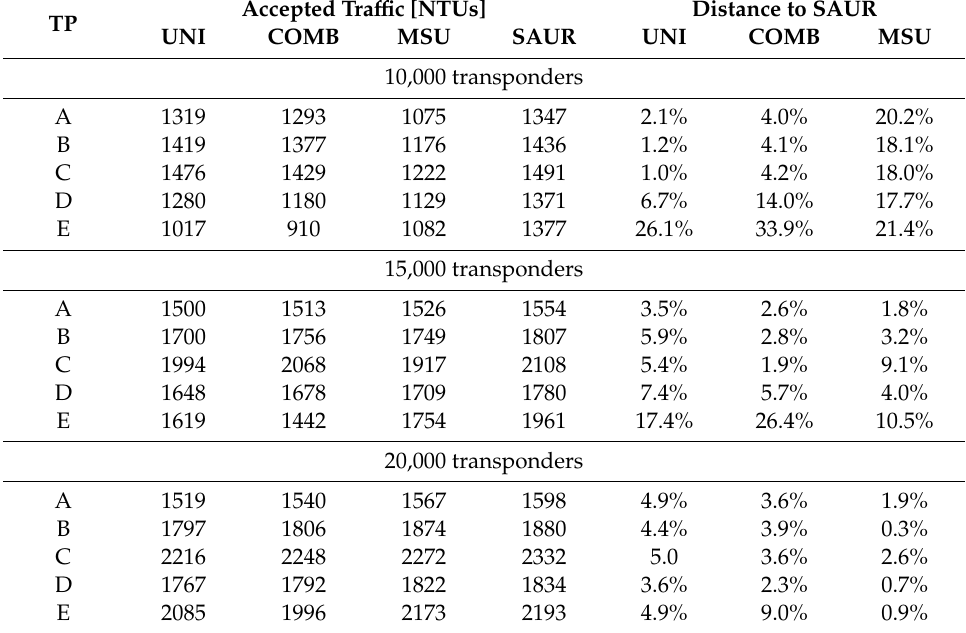
Comparison of algorithms for various number of transponders and tra ffi c profiles, Euro28